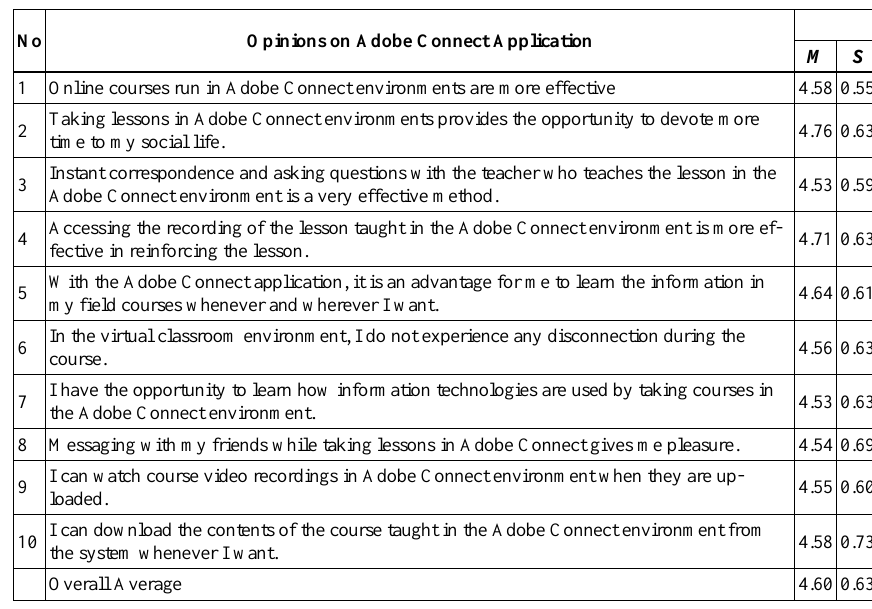
Table 6. University students' opinions on Adobe Connect